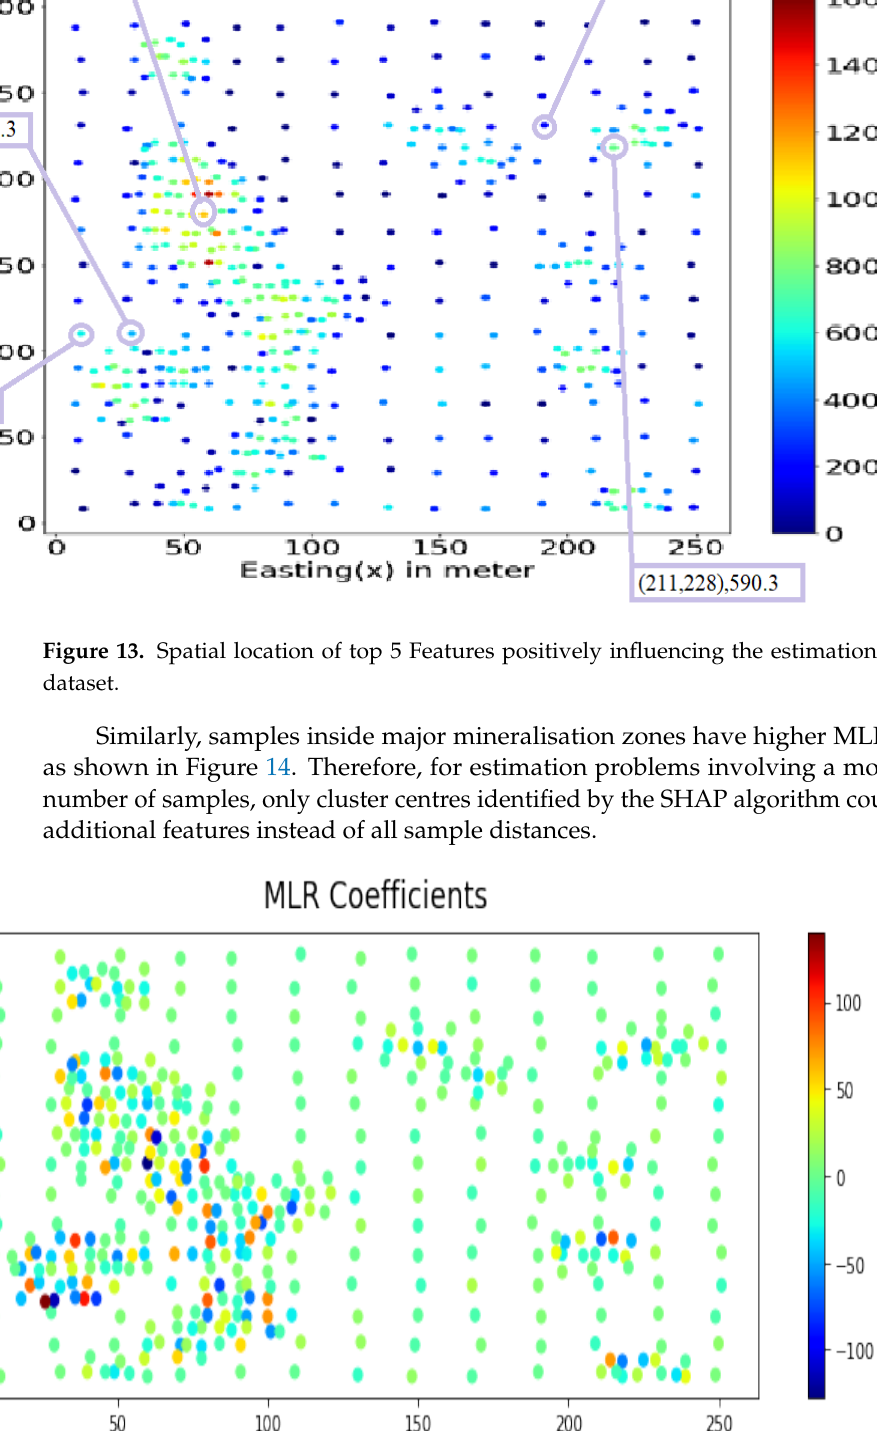
Figure 12. Top 10 Features (samples) positively influencing the spatial estimation process in Walk- erlake dataset.